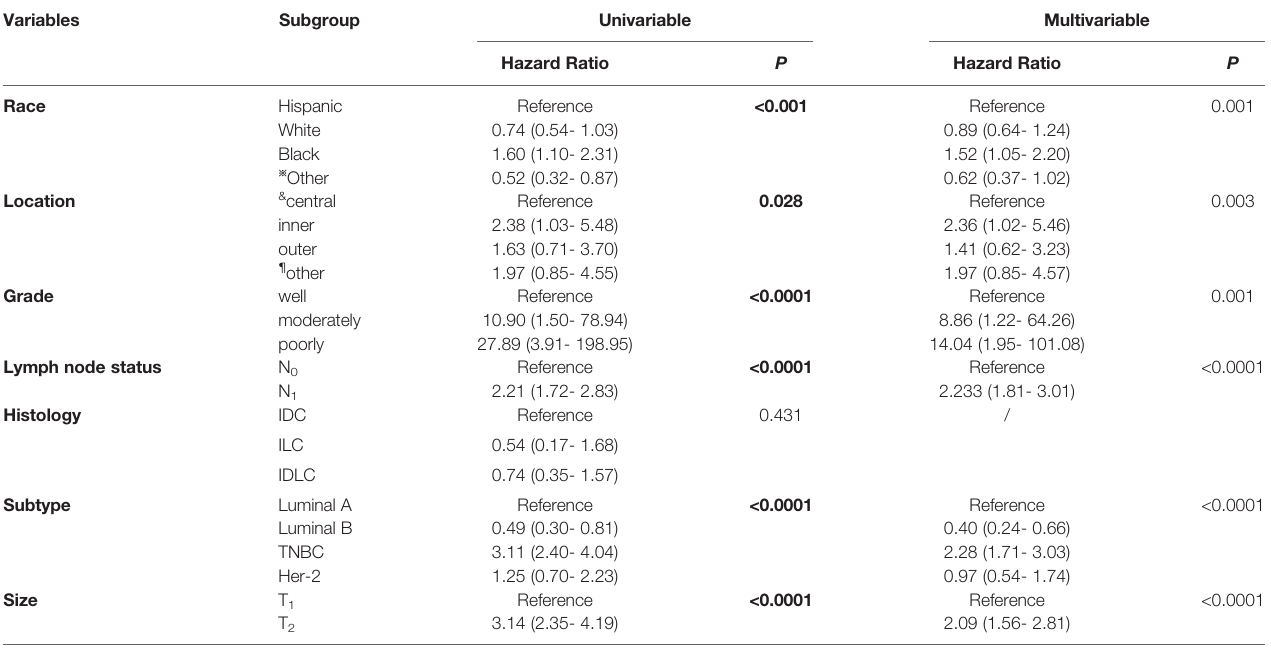
TABLE 2 | Univariate and multivariate Cox regression analyses of predictive variables correlated with CSS in young women with early-stage breast cancer.